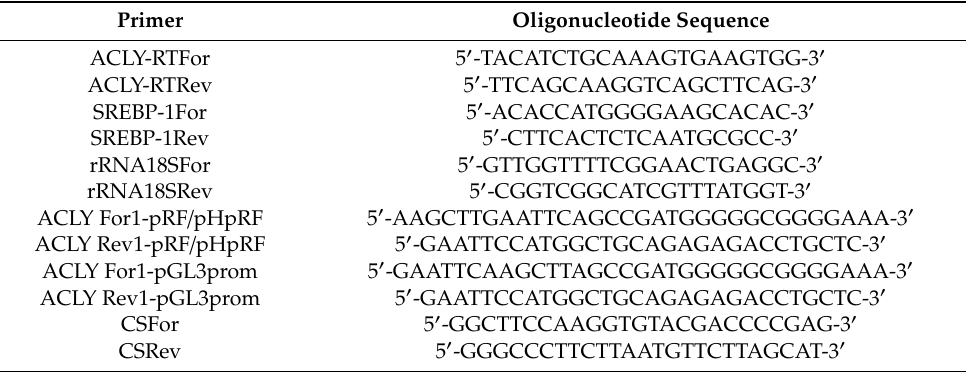
Table 1. Oligonucleotides used for qRT-PCR analysis, for construction of monocistronic and dicistronic vectors, and for the evaluation of cryptic